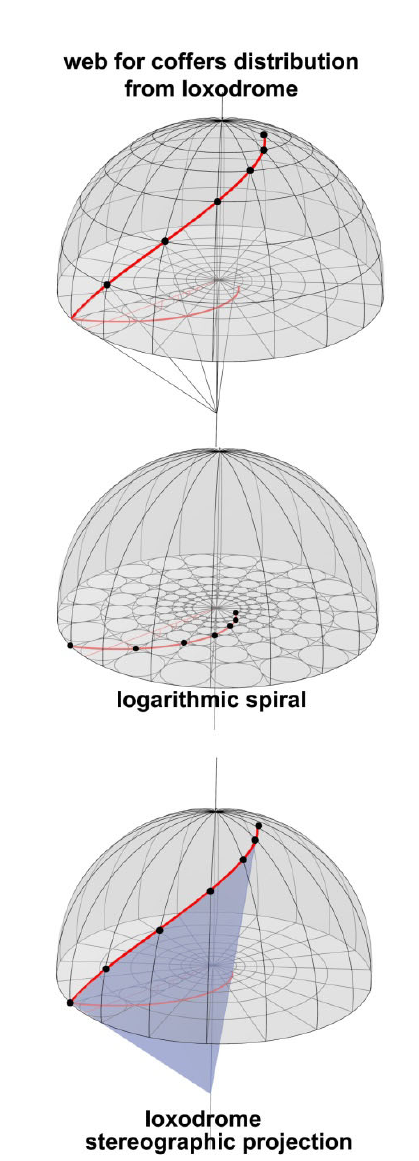
Figure 11. Web for coffers distribution on hemispherical dome staring to Archimede rules and the theorem of Apollonio